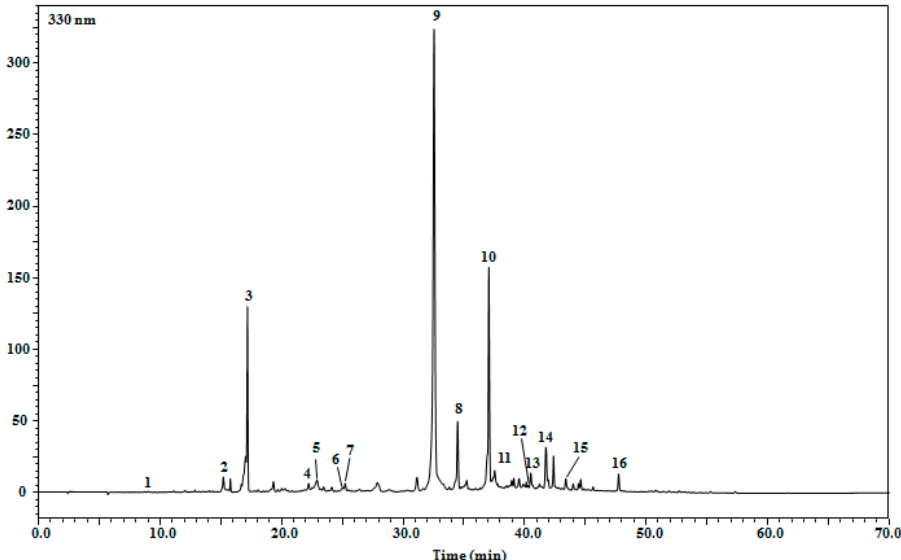
Figure 1. Chromatographic profile of phenolic compounds in Origanum compactum extract (EtOH:H 2 O 7:3 v / v ) acquired at 330 nm. Table 2. Tentative characterization of phenolic compounds in (EtOH:H2O 7:3 v/v ) extract of Origa- num compactum by HPLC-PDA/MS. Peak N°